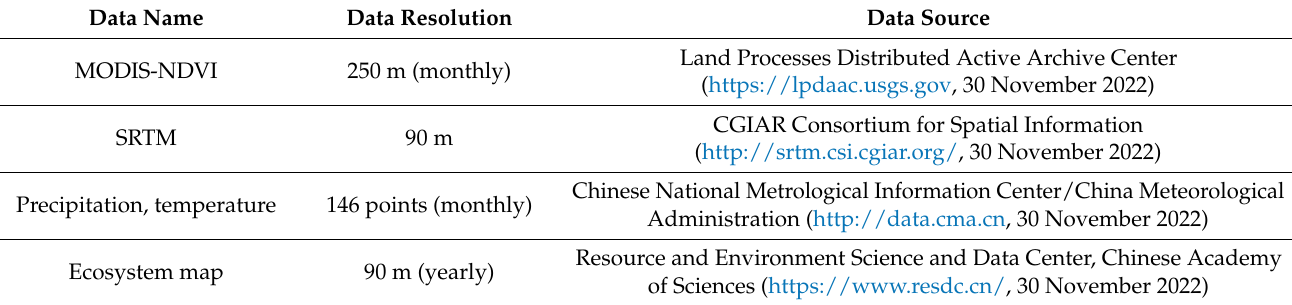
Table 1. Sources of principal data.